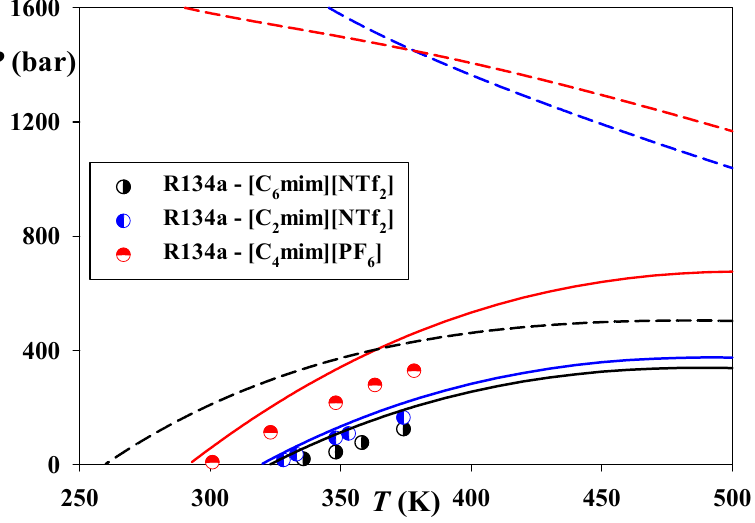
Figure 6. Critical loci in the systems of R134a and [C 6 mim][NTf 2 ], [C 2 mim][NTf 2 ], and [C 4 mim][PF 6 ]. Points — experimental data [84]. Solid lines — predictions of CP-PC-SAFT, dashed lines — predictions Points—experimental data [84]. Solid lines—predictions of CP-PC-SAFT, dashed lines—predictions of SAFT-VR-Mie. k 12 = 0 for both models. of SAFT-VR-Mie. k 12 = 0 for both